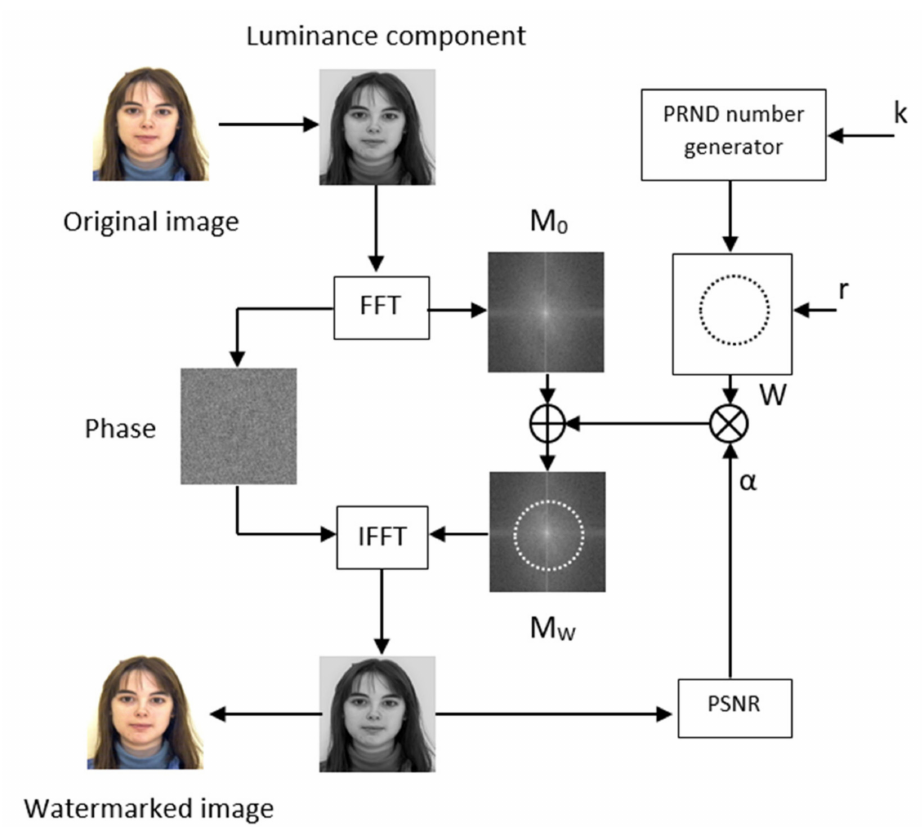
Figure 2. Fourier watermark insertion